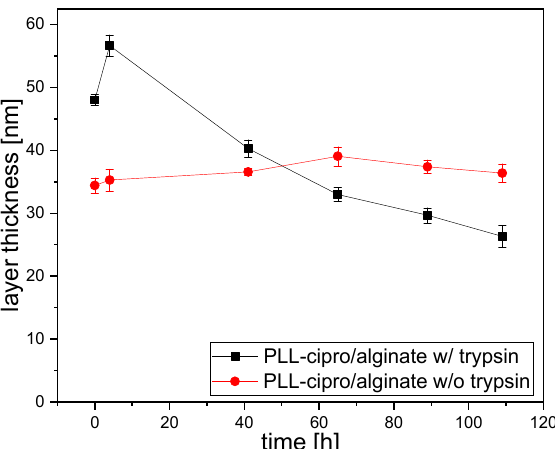
Figure 5. Dry layer thickness of PLL-cipro/alginate coatings as determined by ellipsometry after incubation in PBS buffer with or without addition of trypsin (5 µg/mL) at pH 7.4 and at 37 °C.